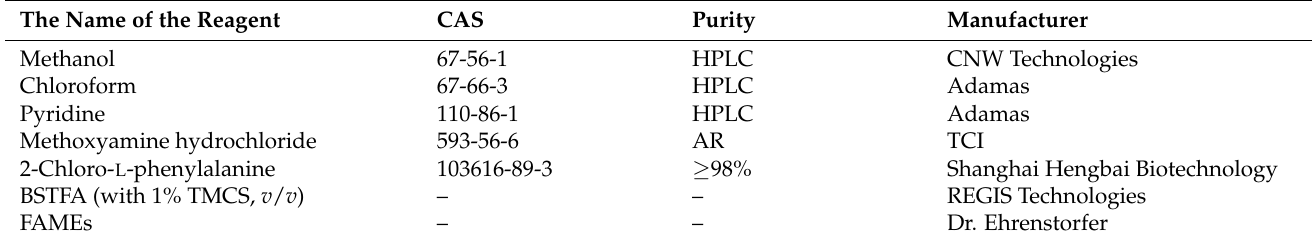
Table 1. List of laboratory